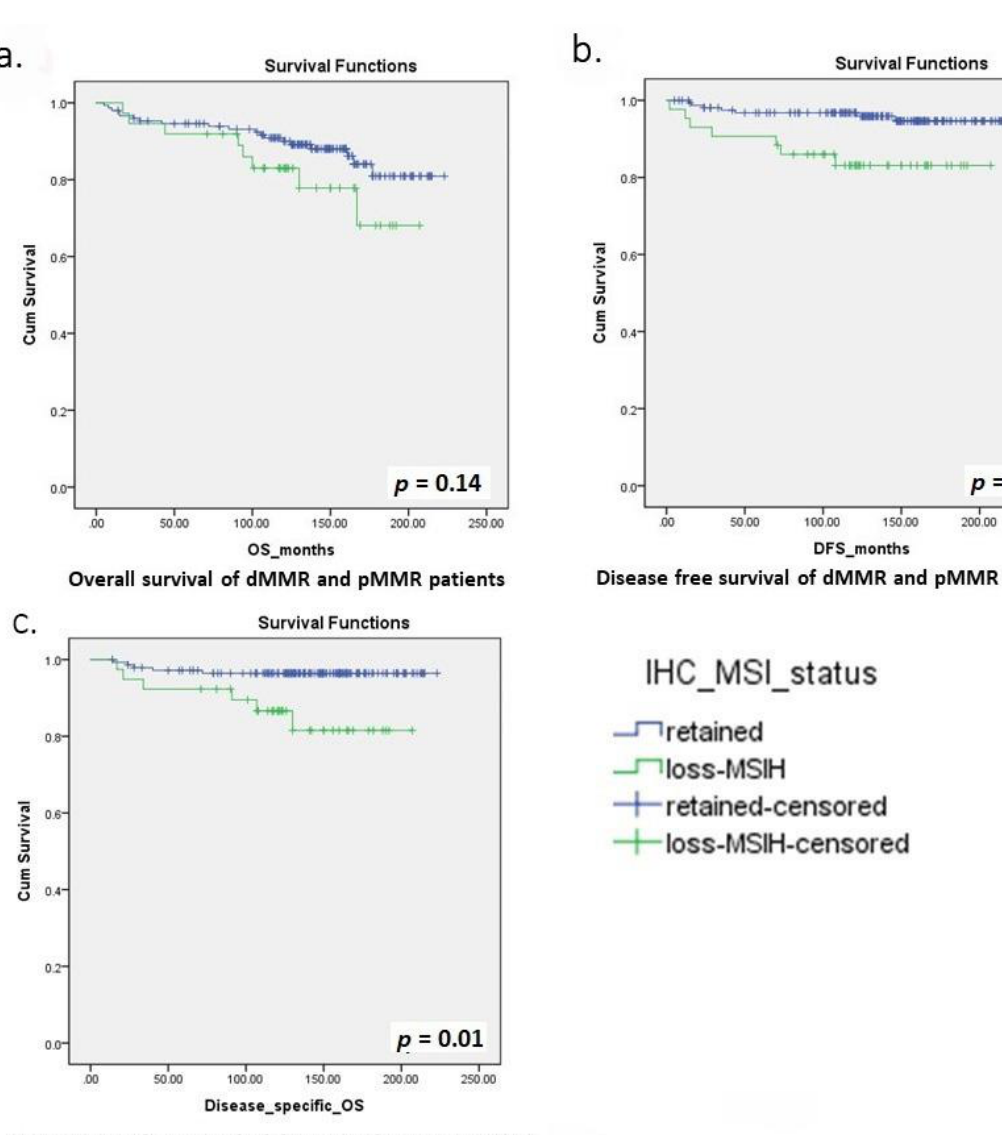
Figure 2. Kaplan–Meier curves for overall survival (OS), disease-free survival (DFS) and disease-specific survival (DSS) of dMMR and pMMR patients. ( a ) overall survival, ( b ) disease-free survival, and ( c ) disease-specific survival of dMMR and pMMR patients.